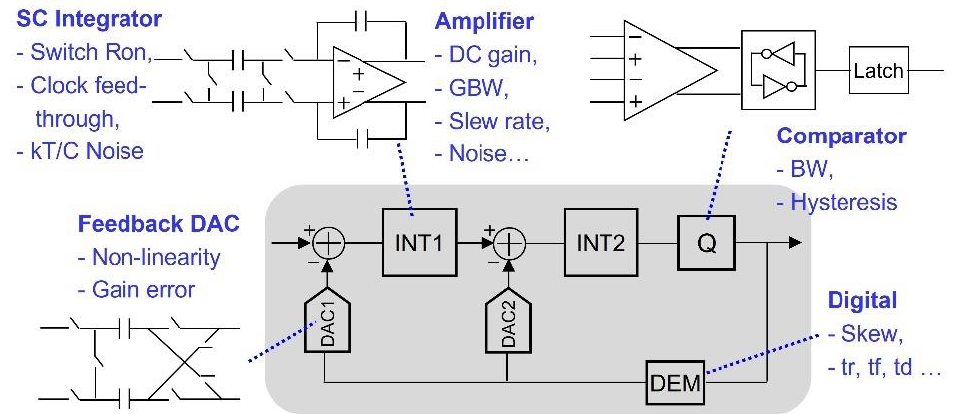
Figure 1. Block diagram of a second order discrete-time sigma-delta modulator.